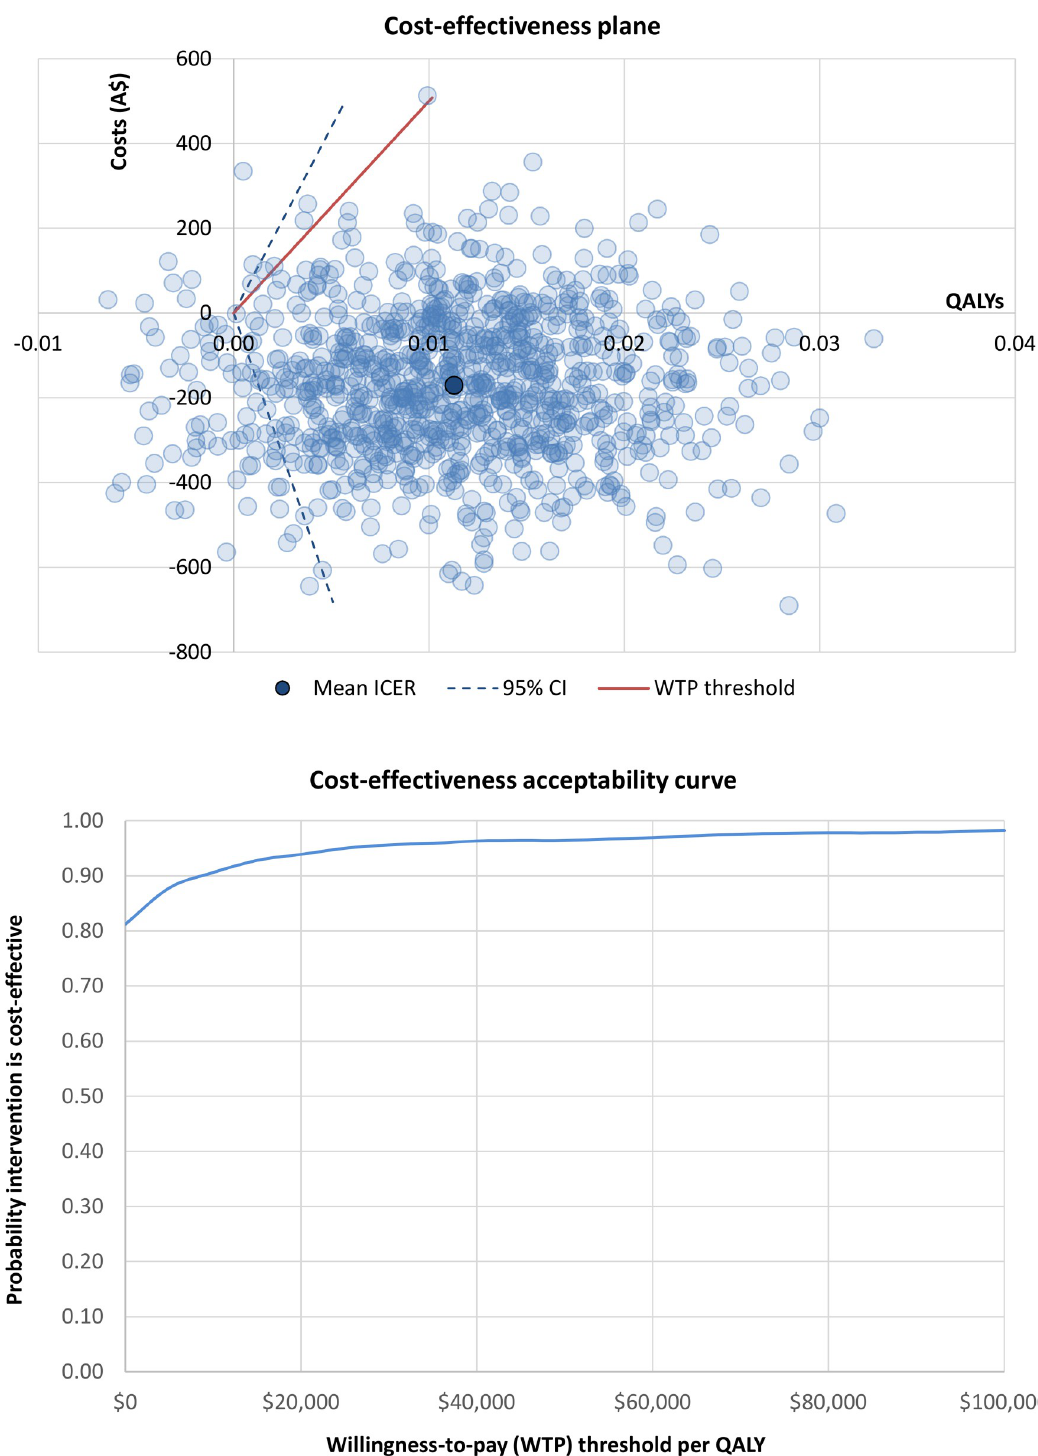
Fig 1. Cost-effectiveness results for the health sector perspective across all participants at 12 months. Abbreviations: A$ = Australian dollars; CI = confidence interval; ICER = incremental cost-effectiveness ratio; QALYs = quality-adjusted life years; WTP = willingness to